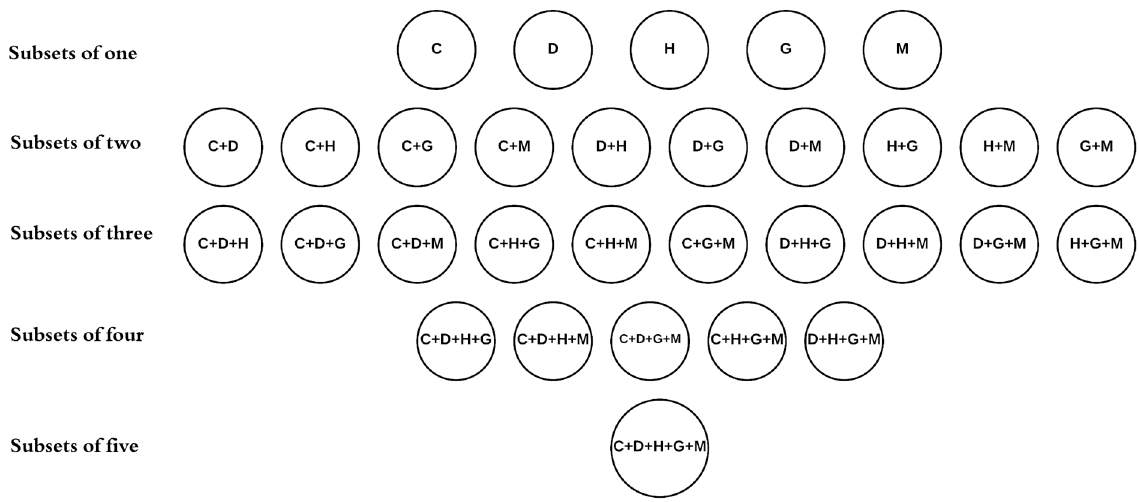
Figure 2. All possible subsets of 5 groups of features, including comorbidities (C), demographics (D), hospital encounter codes (H), GP visits (G), and medications (M).